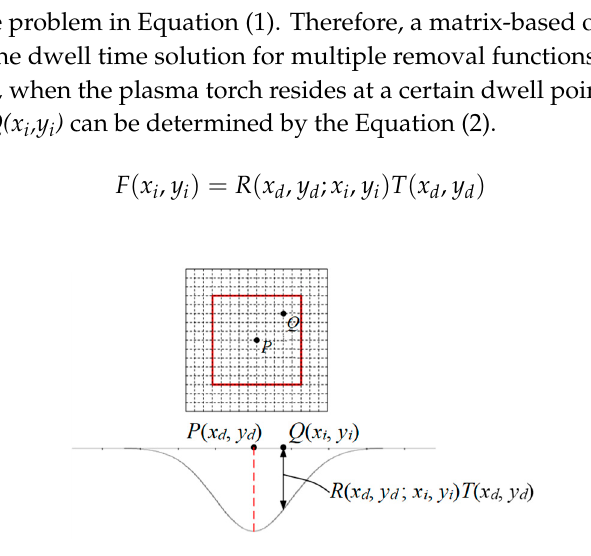
Figure 6. Schematic of the removal amount on dwell points.